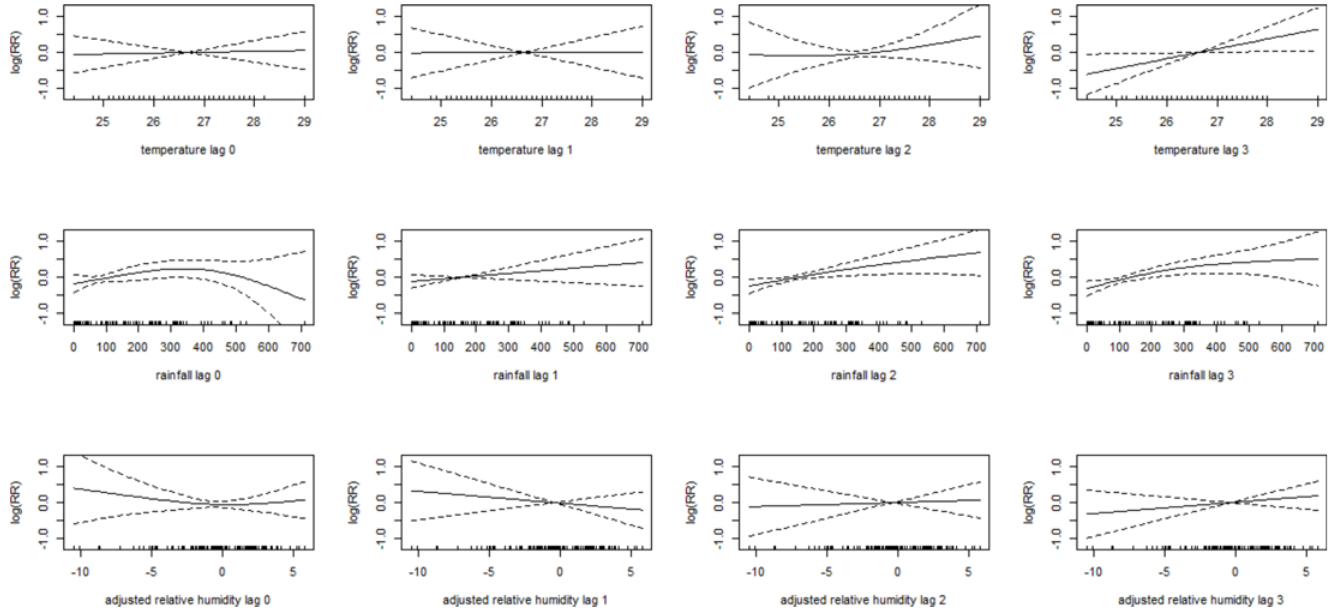
Fig 3. Association between Meteorological Variables and Dengue over Lag 0 – 3. Solid lines represent relative risks of dengue cases and dotted lines depict the upper and lower limits of 95% confidence intervals.